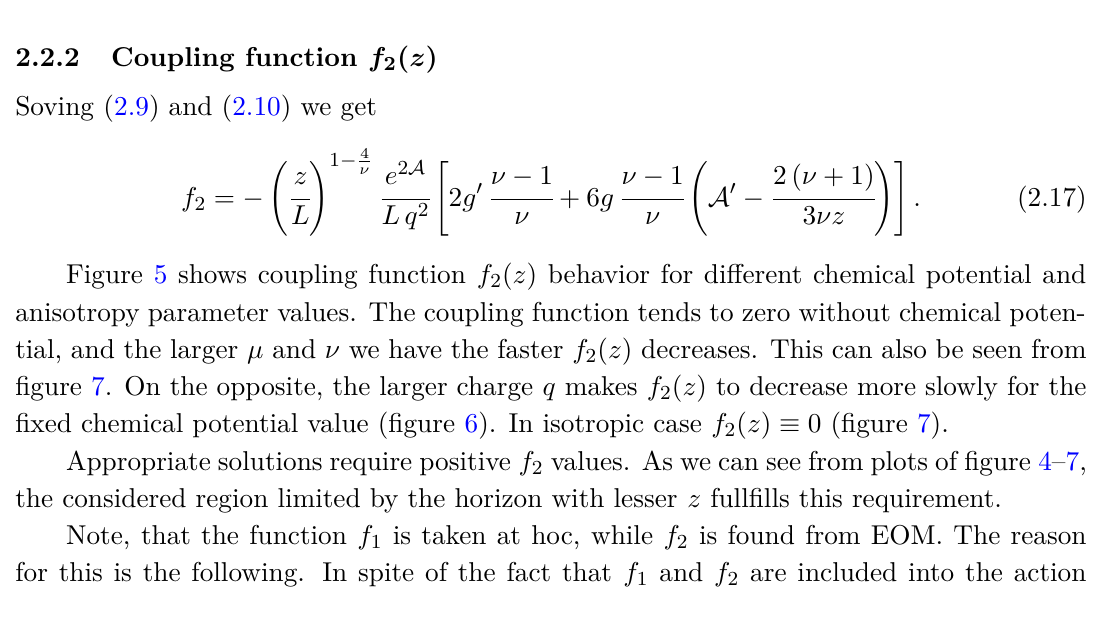
Figure 4 . Blackening function g ( z ) in isotropic and anisotropic cases ( ν = 1 , 1 . 5 , 3 , 4 . 5 ) for µ = 0 (A), µ = 1 (B), µ = 2 (C) and µ = 3 (D); a = 4 . 046 , b = 0 . 01613 , c = 0 . 227 , z h = 1